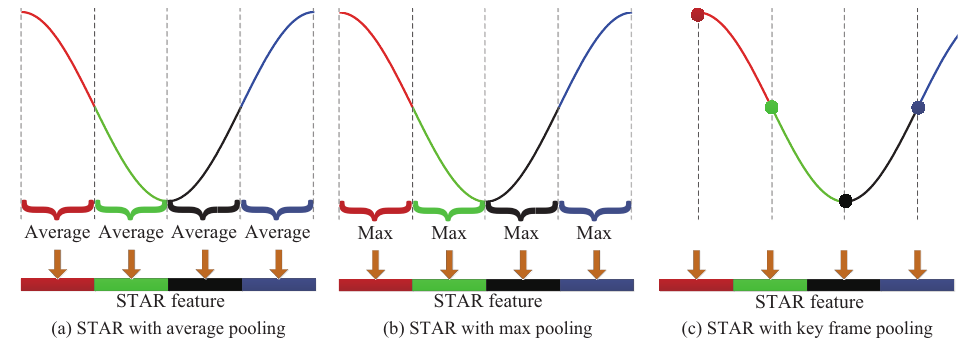
Figure 7. Illumination of temporally aligned pooling representation, with M = 4. Three pooling manners for temporal alignment are presented: ( a ) average pooling, ( b ) max pooling, and ( c ) key frame